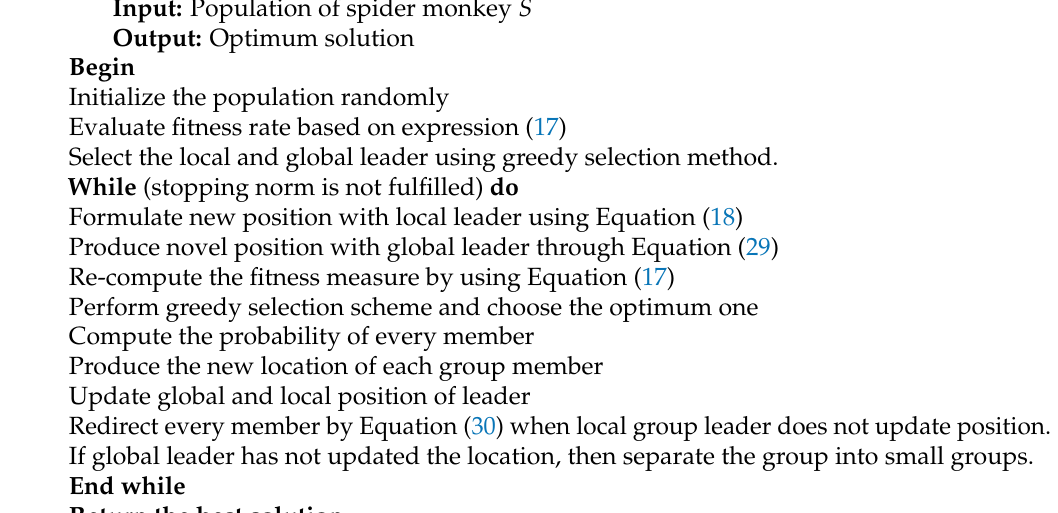
Algorithm 1 Pseudo-code of proposed TD-Spider Taylor